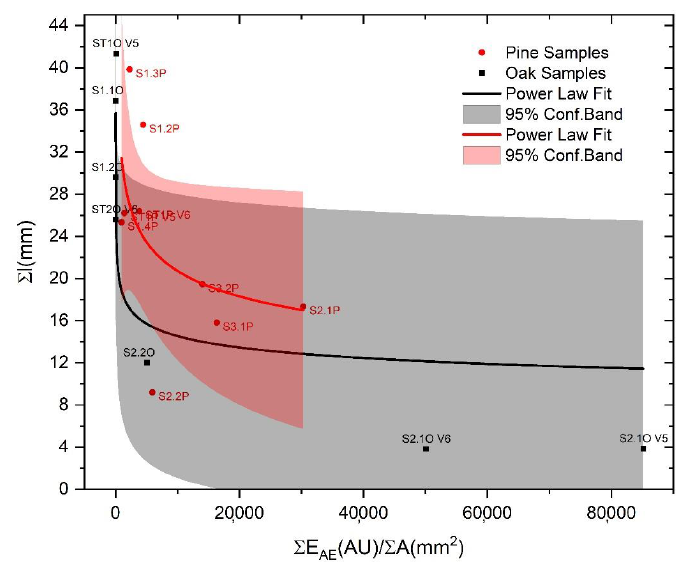
Figure 11. Relationship of the total dynamic surface energy value (DSV) vs. the maximum crack propagation for the two tested wooden species (oak, black dots and line; pine, red dots and line). Lines, power law best fits from experimental data; shaded areas, 95% confidence band for experimental data.